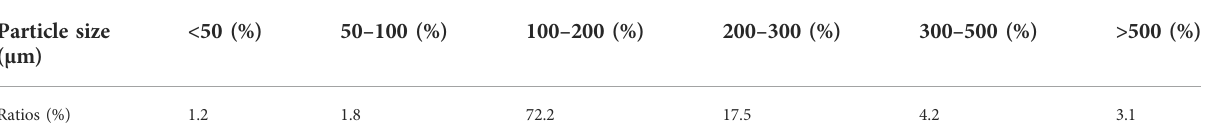
TABLE 1 Particle size of natural wind sand.